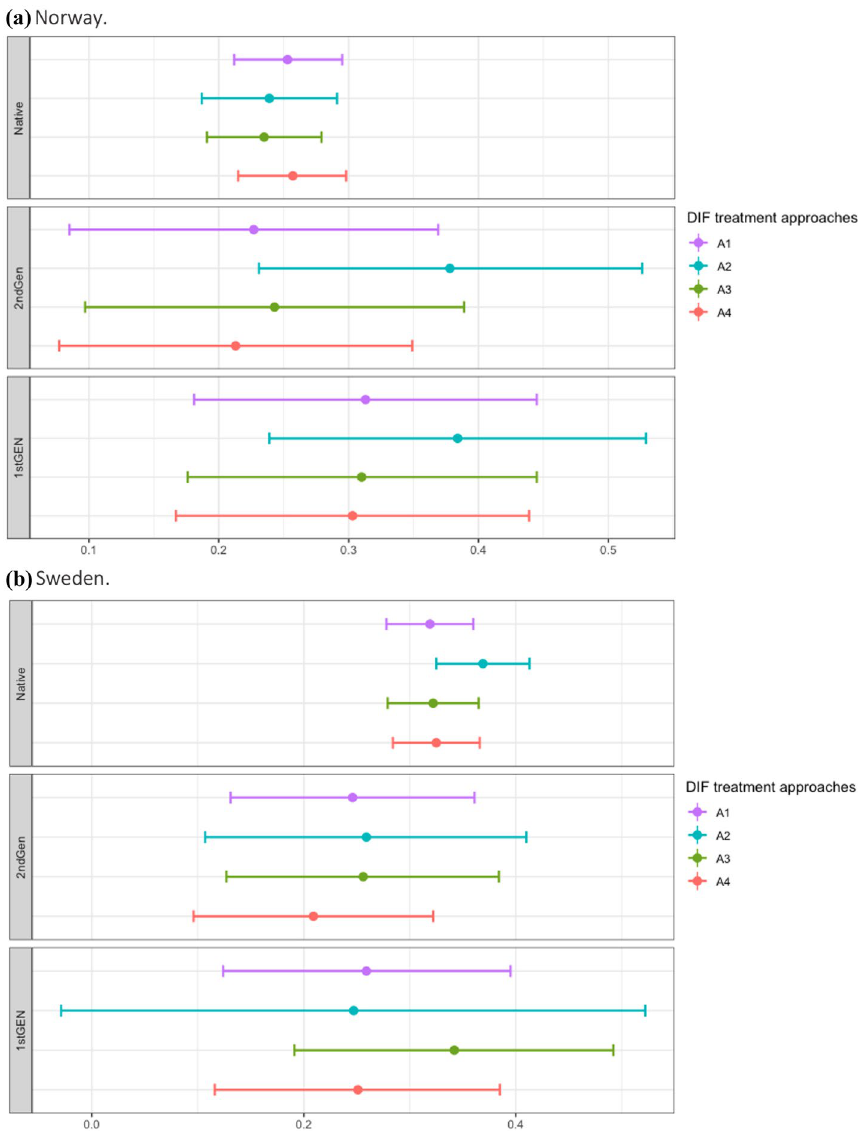
Fig. 3 The change in the strength of the HOMEPOS–Achievement relationship with different DIF treatment approaches. The bars reflect the 95% confidence